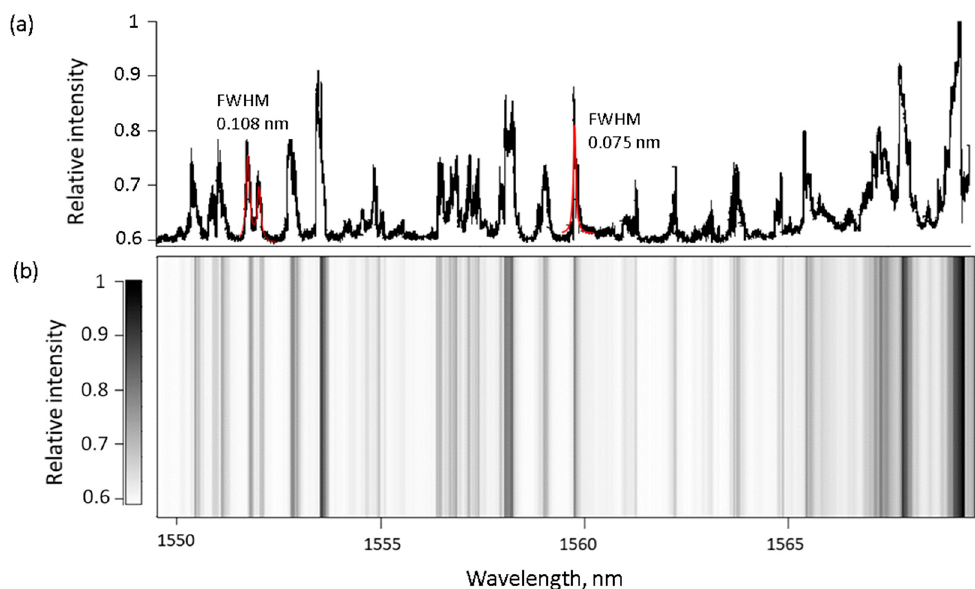
Figure 2. ( a ) Light intensity of one PMMA microsphere (diameter 50 µ m) attached to a tapered fiber. Intensity peaks show at what wavelength WGMs were excited. The vertical axis shows normalized light intensity values (average scattered light from all regions of the microsphere). ( b ) Light intensities for various wavelengths are plotted in a barcode system. The red lines in Figure 2a are Lorentz functions fitted to different peaks. The narrowest peak was around 1560 nm. The FWHM linewidth was measured to be 75 pm. The Q factor of 2.1 × 10 4 was calculated. This result was close to the measured upper limit for PMMA microspheres [18].